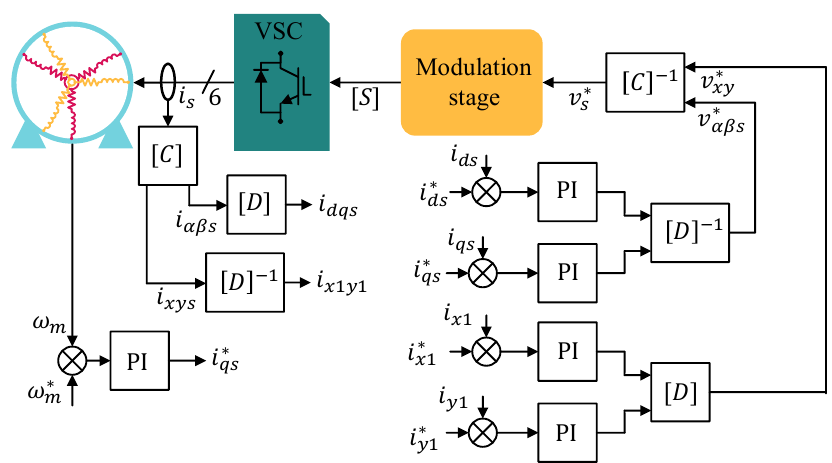
Figure 3. Standard version of an IRFOC scheme for a six-phase electric drive where the variable ω ∗ m identifies the reference